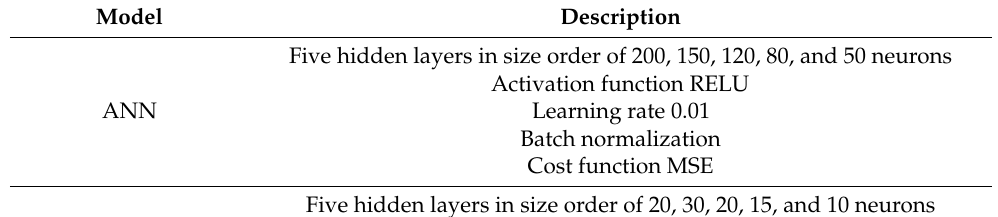
Figure 4. The Proposed 2D CNN–LSTM Model Architecture. Table 2. Information of